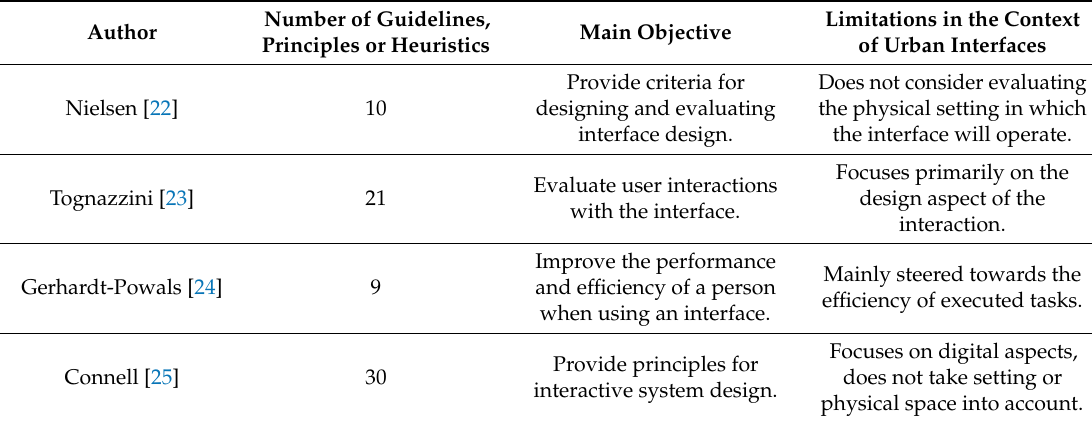
Table 1. Summary of Revised Usability Heuristics and